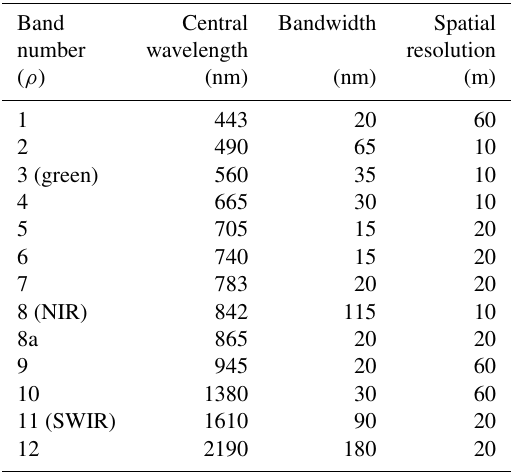
Table 1. Sentinel-2 spectral bands and spatial